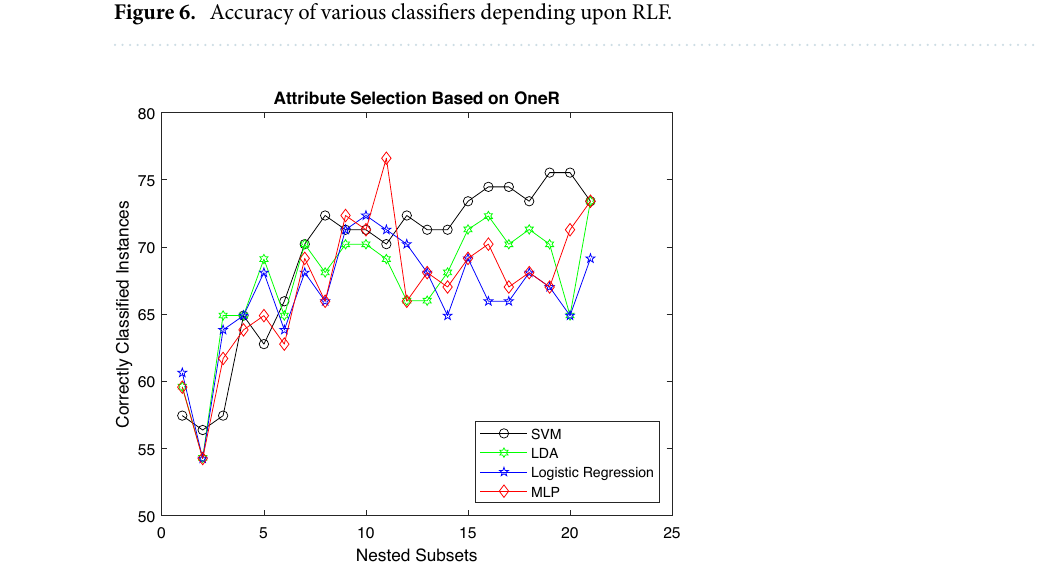
Figure 6. Accuracy of various classifiers depending upon RLF.